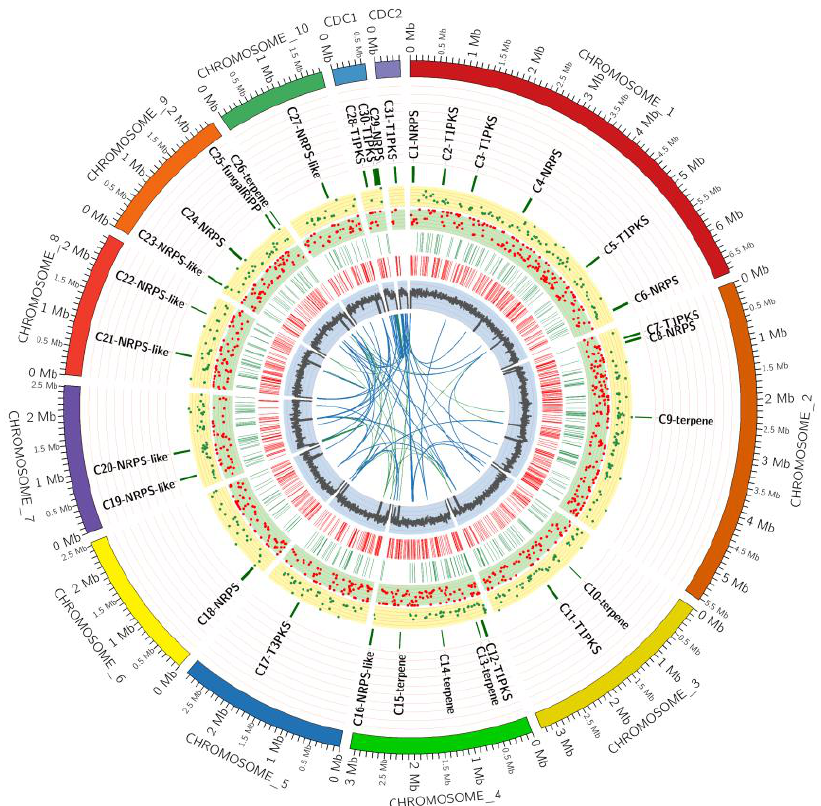
Figure 4. Circos diagram is an effective visual tool for displaying the common differences in gene expression in Alternaria alternata inoculated on a host plant compared to uninoculated treatment at 12, 24, and 48 h post-inoculation. Each concentric circle, starting from the outermost layer and moving toward the center, represents chromosomal locations, secondary metabolite gene clusters, differentially expressed genes (DEGs) that are commonly up-regulated or down-regulated in the three infection stages, and GC content. At the very center, gene duplications are represented. Notably, red dots signify transcripts that have been significantly up-regulated (FDR < 0.05) in A. alternata inoculated on a host plant, while green dots signify transcripts that have been significantly down- regulated (FDR < 0.05).